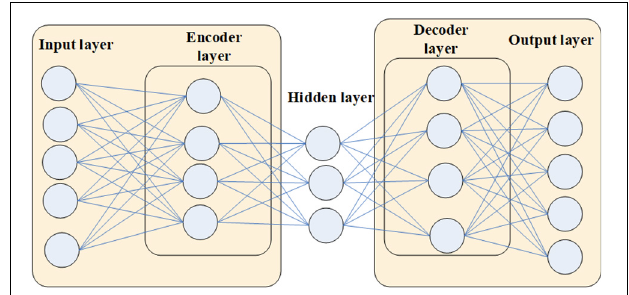
FIGURE 1 | Structure of the